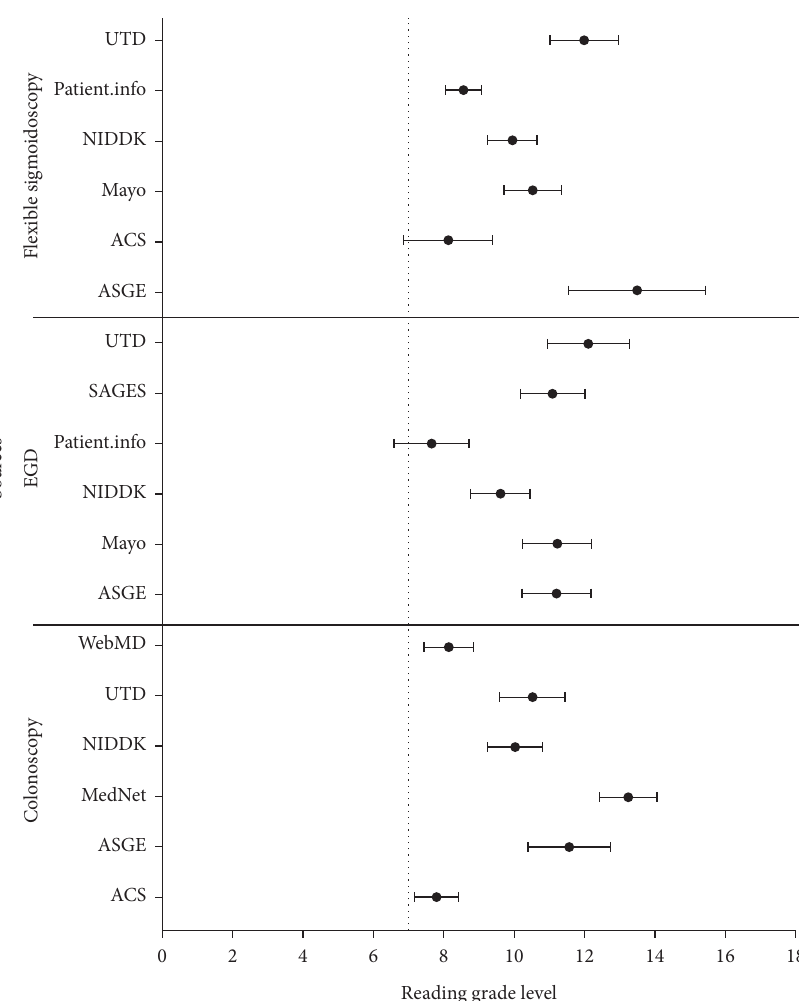
Figure 5: Forest plot represents the mean and 95% confidence interval of each of the procedures. With the exception of the American Cancer Society for Flexible Sigmoidoscopy and Patient.info for EGD, all studies were significantly above the recommended reading grade level of the 7 th grade.